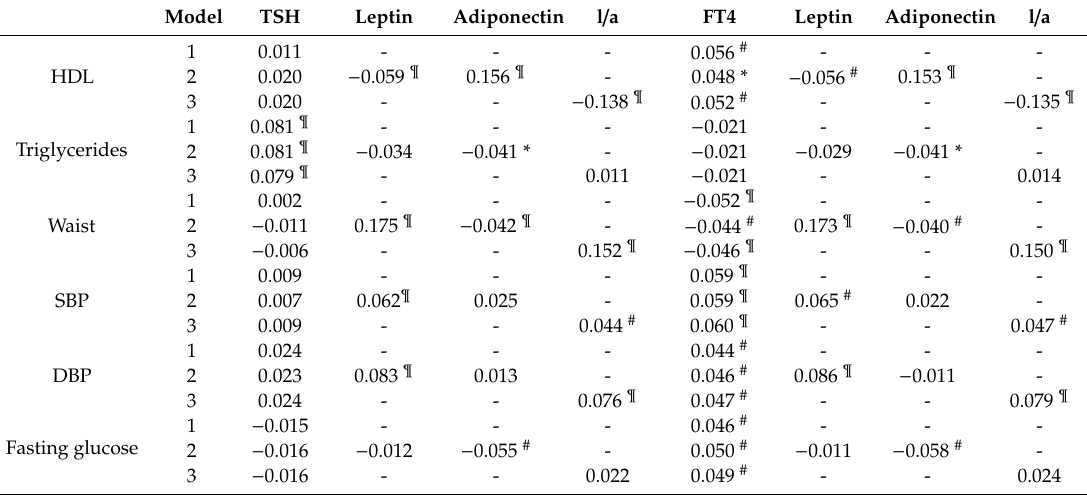
Table 3. Association of thyroid function with components of the metabolic syndrome in